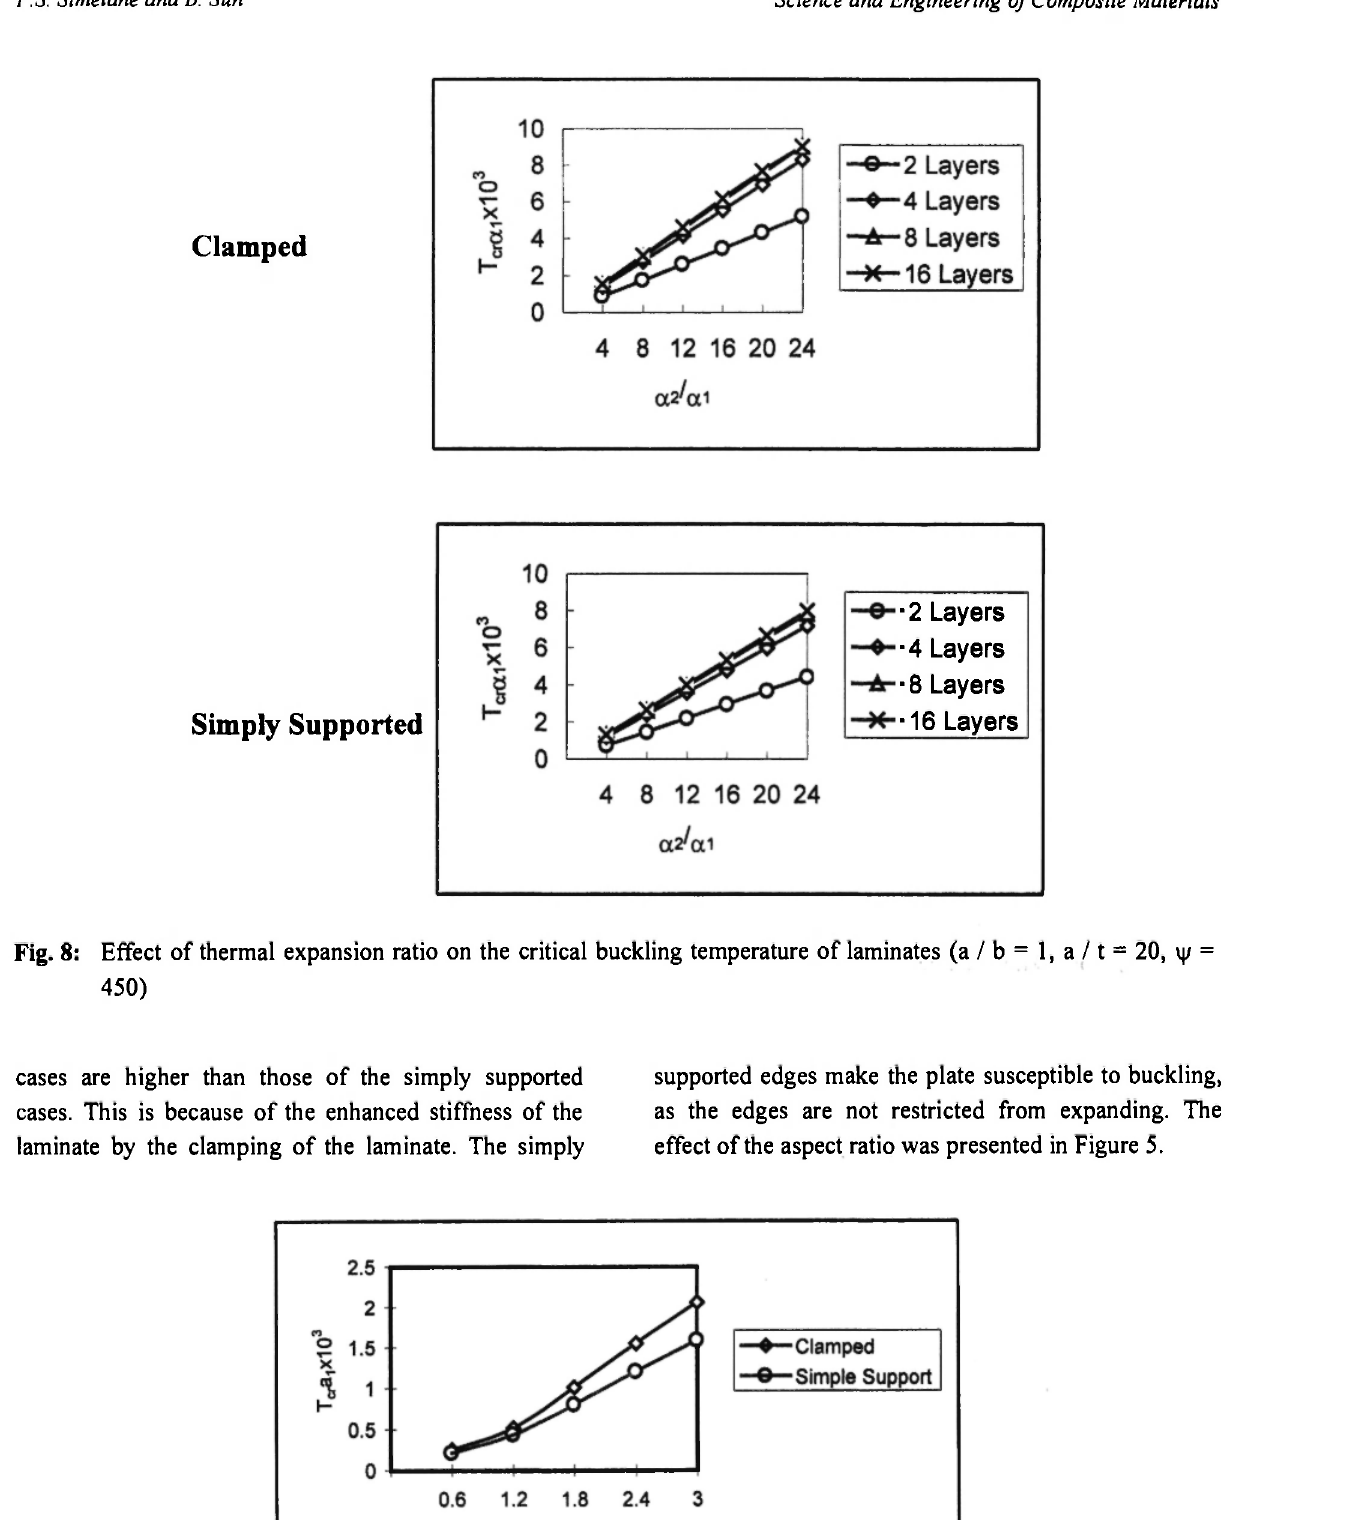
Fig. 9: Influence of boundary condition and aspect ratio on the critical buckling temperature of laminates (a/t =20, Ν = 4, ψ =